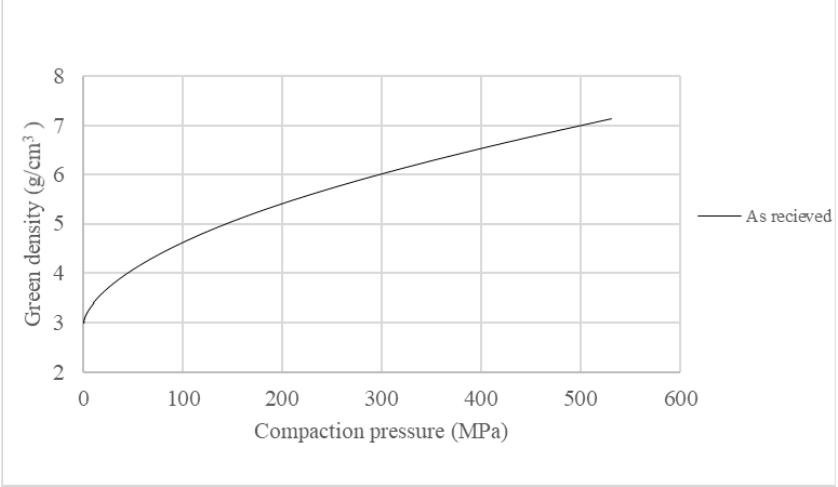
Figure 7. Compressibility evaluation for pure iron powder type A, without adding a lubricant, in the as received state.